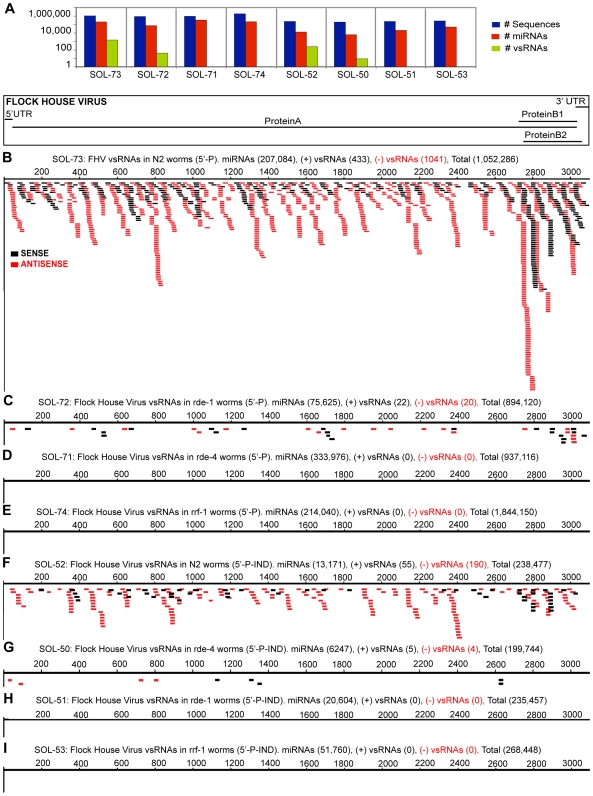
Flock House Virus-derived vsRNAs are more abundant in RNAi-competent worms, and exist as both 5′-monophosphorylated, and 5′-triphosphorylated species.The incidence, strandedness and lengths of vsRNAs are drawn as a function of their position along the viral genome. Each filled box represents one instance of a captured vsRNA, with the lengths of the boxes proportional to the lengths of the vsRNAs. vsRNAs from the positive and negative strands are shaded black and red respectively. All samples were sequenced on Illumina's platform. (2A) Sequence counts for all small RNAs, miRNAs, vsRNAs (Y-axis: log scale). 5′-P vsRNAs from wild-type Bristol N2 (2B; Sol-73), rde-1 (2C; Sol-72), rde-4 (2D; Sol-71), and rrf-1 (2E; Sol-74) worms, 24 hours post-heat-shock. 5′-xP vsRNAs from wild-type Bristol N2 (2F; Sol-52), rde-4 (2G; Sol-50), rde-1 (2H; Sol-51), and rrf-1 (2I; Sol-53) worms, 24 hours post-heat-shock.